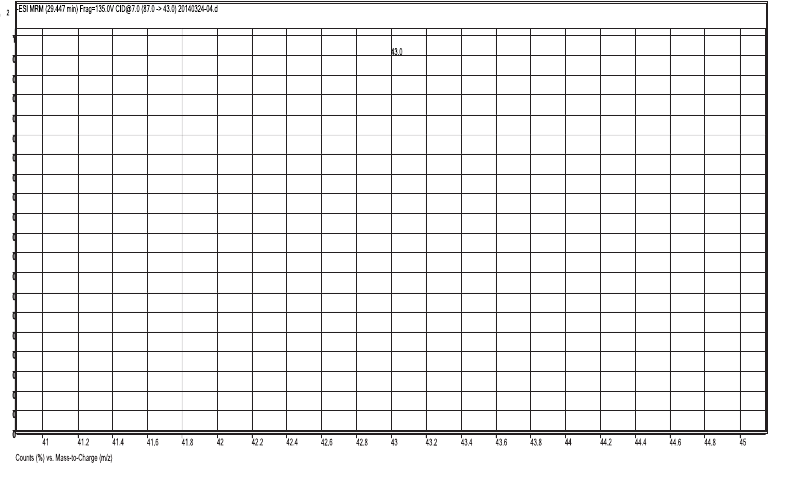
Fig. 10. Spectrum. of pyruvic acid with triple quadrupole